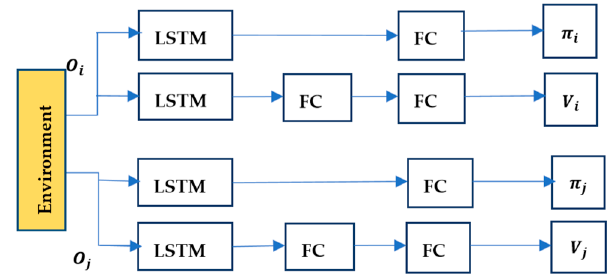
Figure 1. The network structure of the Multiagent Independent Proximal Policy Optimization (MAIPPO) algorithm.